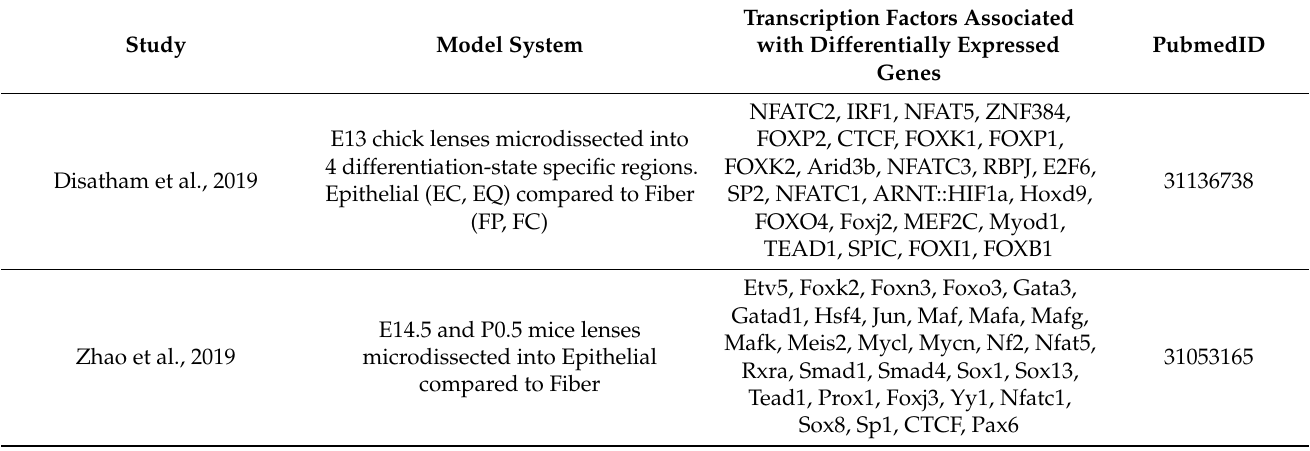
Table 3. Transcription factors with enriched binding motifs in open chromatin regions mapped with ATAC-seq studies in mice and chicken